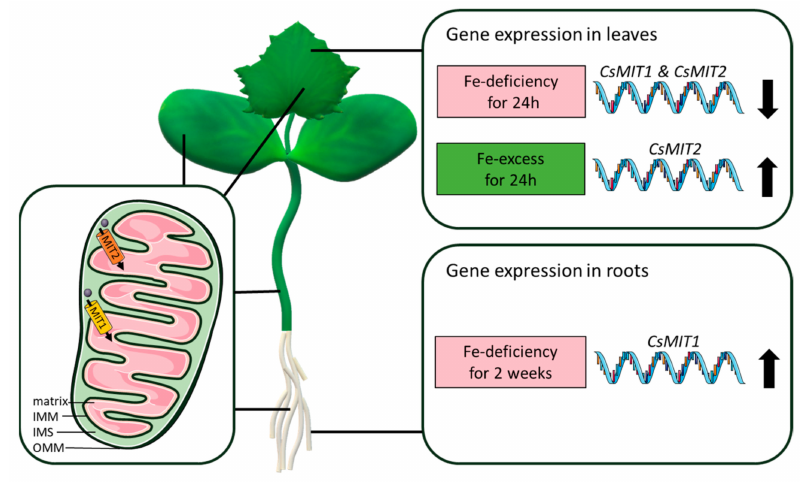
Figure 6. Possible role of mitoferrins in cucumber cells and their gene expression under different iron